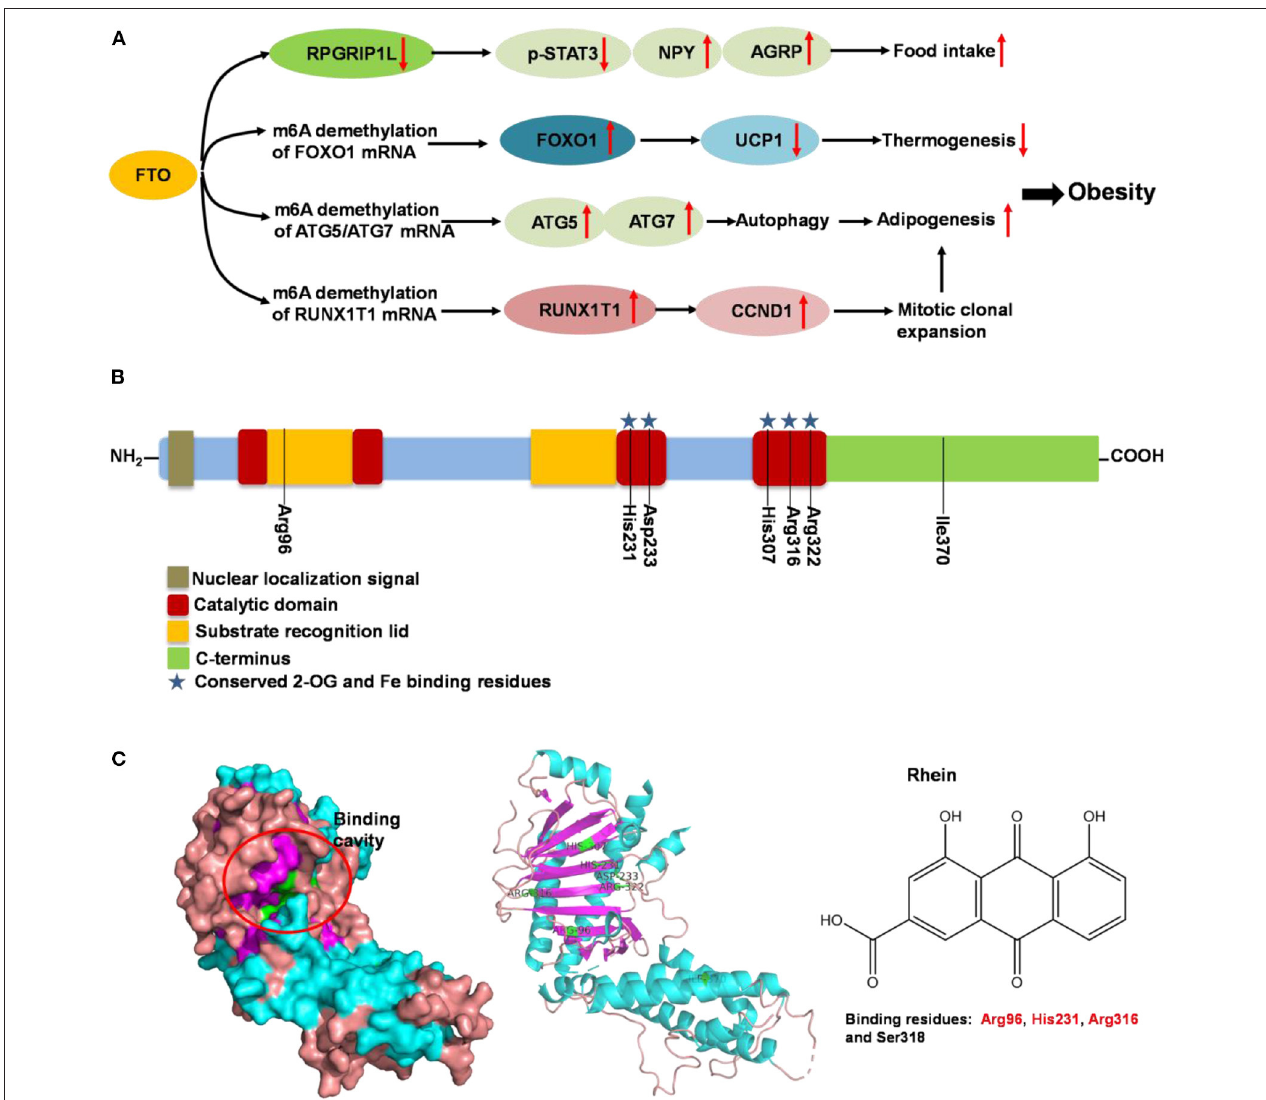
FIGURE 5 | Summary of molecular mechanism of FTO-induced obesity, FTO protein structure and its binding with rhein. (A) Mechanism of FTO-induced obesity through regulating food intake, thermogenesis and adipogenesis. (B) Domain structures of FTO protein. Seven amino acid residues (Arg96, His231, Asp233, His307, Arg316, Arg322, and Ile370) are responsible for FTO activity. (C) Binding cavity and residues of FTO protein with rhein. The potential binding residues of FTO are highlighted using red